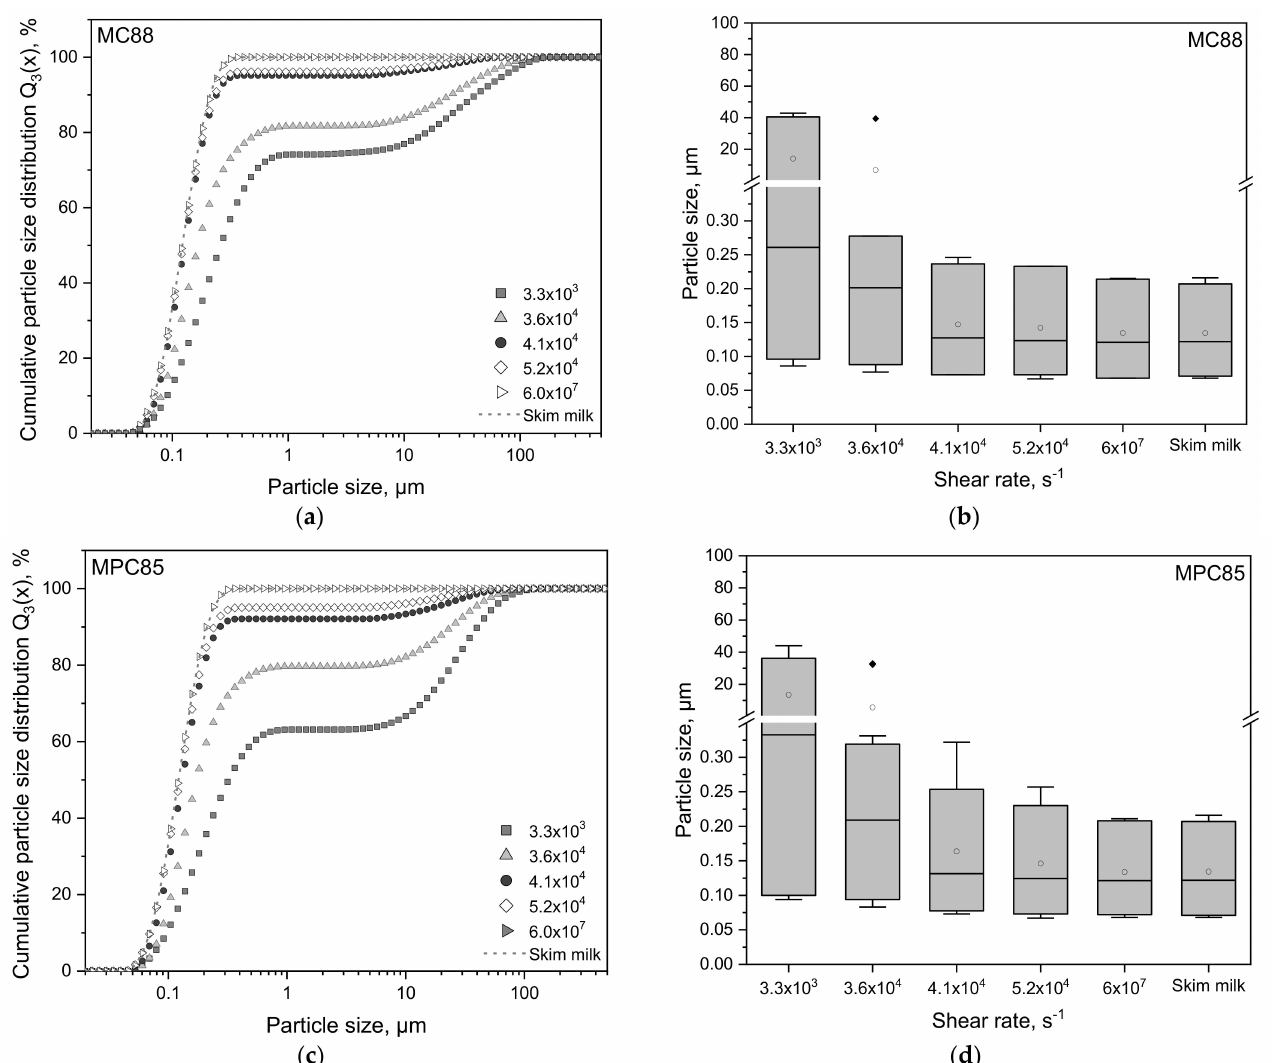
Figure 2. Cumulative particle size distributions Q 3 (x) (volume % vs. diameter) (left) and d 10,3 , d 50,3 , and d 90,3 presented as boxplots (right) of skim milk and skim milk enriched with MC88 ( a , b ) and MPC85 ( c , d ) after homogenization with colloid mill (3.3 × 10 6 –5.2 × 10 4 s − 1 ) and high-pressure homogenizer (6.0 × 10 7 s − 1 ) at 40 ◦ C. Boxplots: The low and high quartiles, the median, and the mean ( (cid:3) ) are plotted. ( (cid:7) ) represents